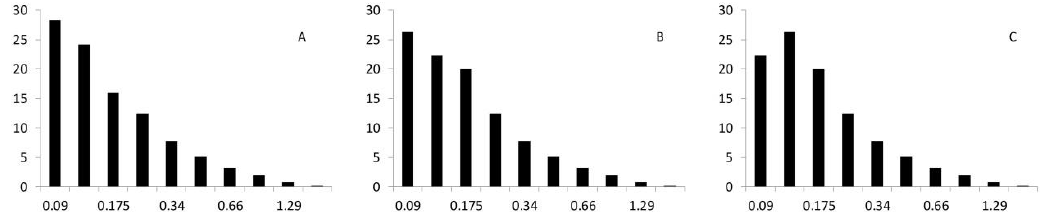
Figure 4. Fiber length distributions. ( A – C ) correspond to the 5%, 7.55% and 10% NaOH treatments, respectively.